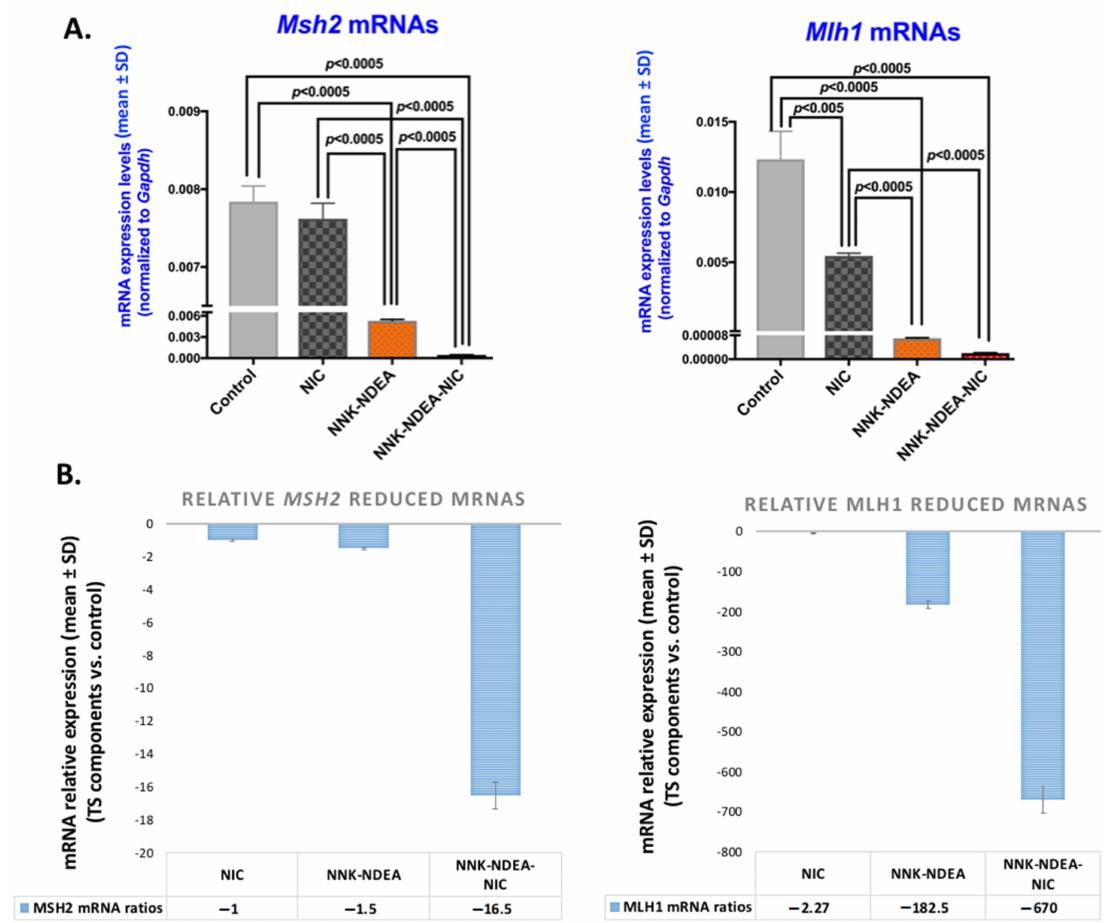
Figure 3. Downregulation of MMR genes in murine HM exposed to TS components. ( A ). Graphs depict mRNA levels of MMR genes, Msh2 and Mlh1 (mRNA levels of genes normalized to Gapdh; by real-time qPCR analysis) in 14-week exposed HM to TS components, nicotine (NIC), N -Nitrosamines (NNK-NDEA), or their combination (NNK-NDEA-NIC), and treated controls. ( p < 0.05 by t test; multiple comparisons by Holm-Sidak; GraphPad Prism 7.0; data obtained from four analyzed samples). (B ) . Graphs depict the mRNA ratios of MMR genes, Msh2 and Mlh1, in HM exposed to smoke components relative to controls (normalized mRNAs (mean ± SD) to Gapdh reference